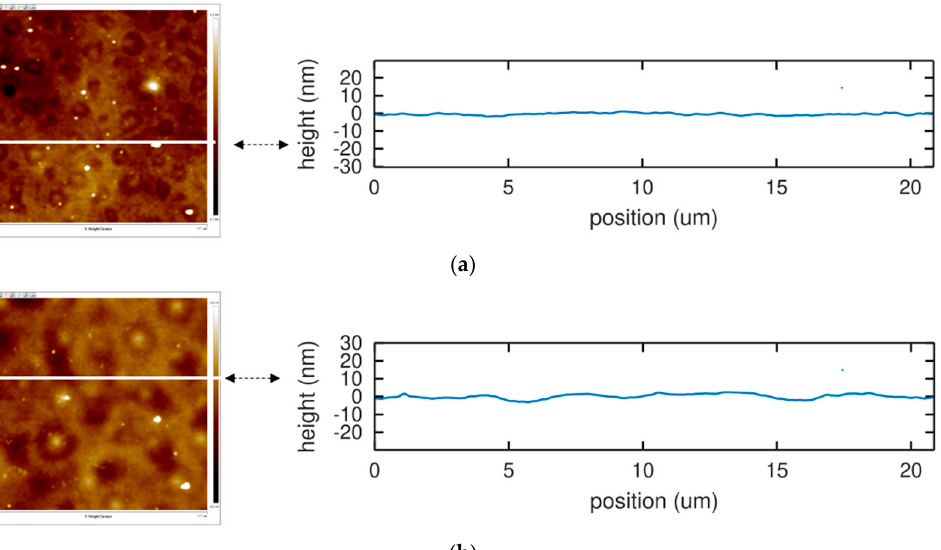
Figure 7. AFM topographies (left) and corresponding height profile along the white line (right) of a silicon surface covered with a spin-coated layer of PBMA (thickness: 500 nm). ( a ) Flat surface after immersion in aqueous PBS solution (pH = 6.2) for 12 h. ( b ) The surface roughness after immersion in aqueous PBS solution with chlorpyrifos solution for 12 h. The PBMA layer is not modified by the presence of chlorpyrifos.